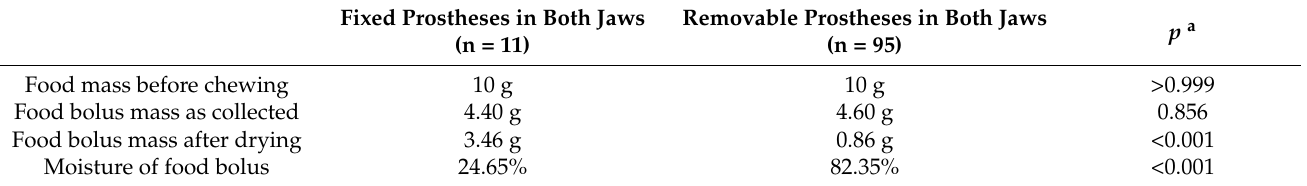
Table 2. Median of mass and moisture of food bolus in patients wearing fixed or removable prostheses. Fixed Prostheses in Both Jaws